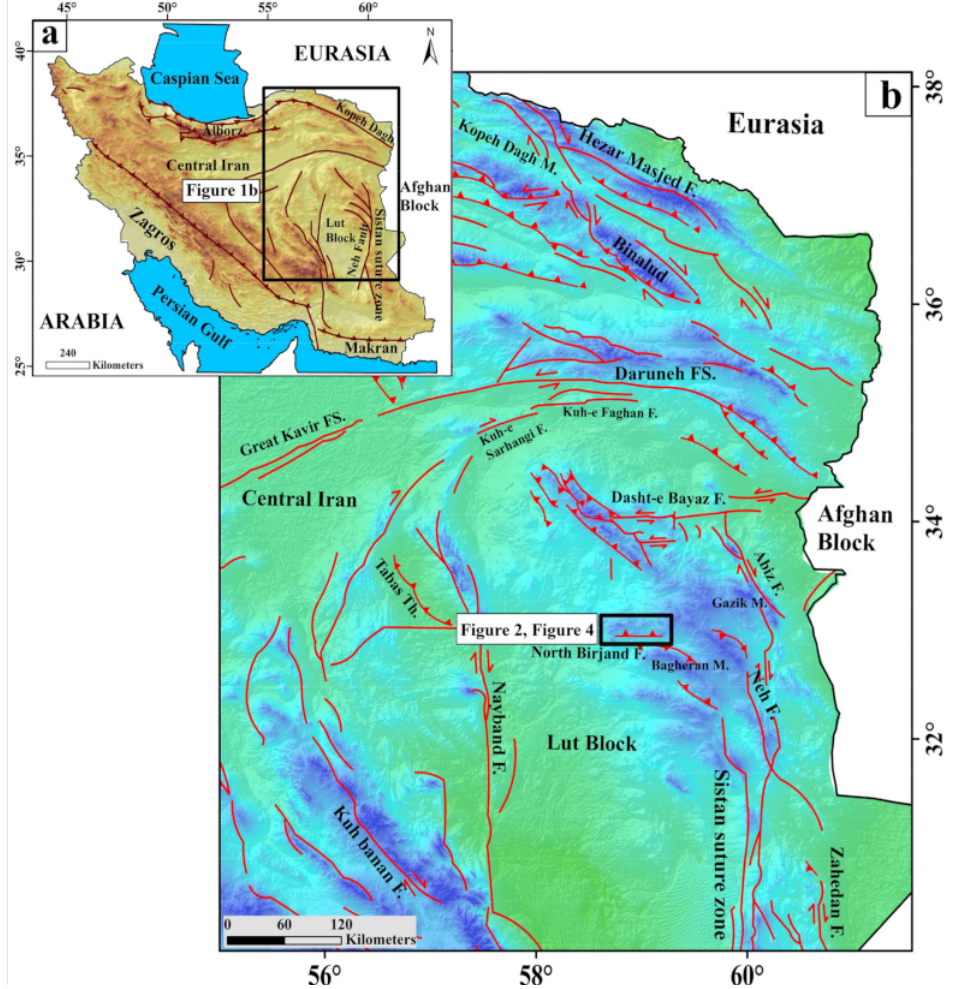
Figure 1. ( a ) Structural zones of Iran and location of eastern Iran (black rectangle); ( b ) structural map of eastern Iran, the black rectangle indicates the location of the region